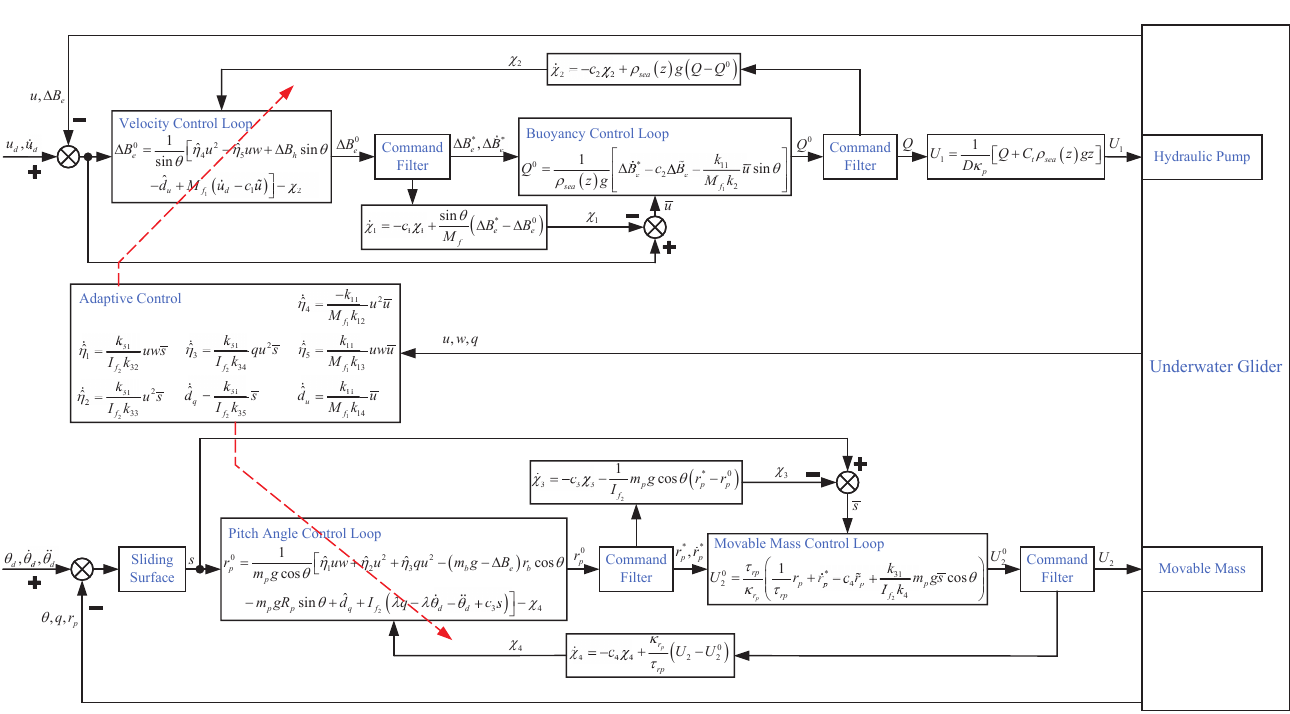
Figure 3. Schematic diagram of the proposed CFAC